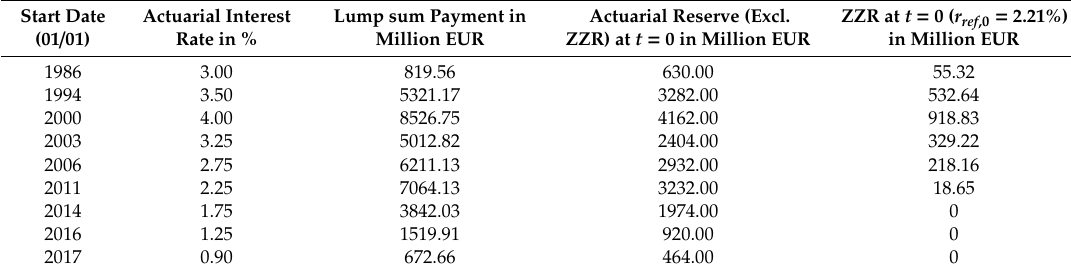
Table 4. Endowments in the